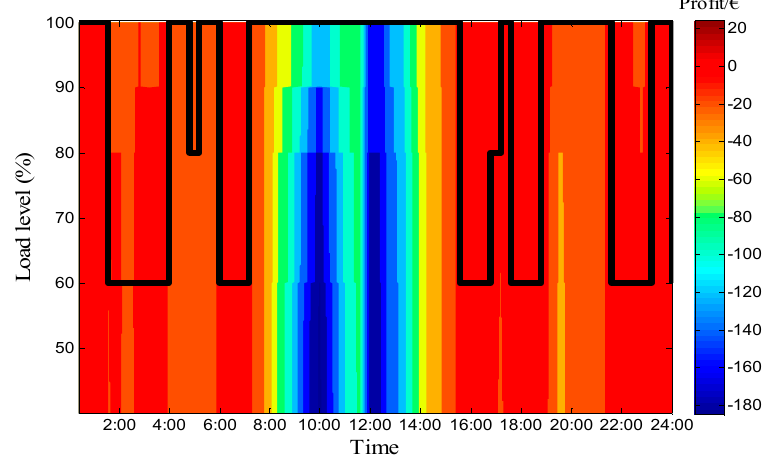
Figure 10. Profit distribution for CHP in real time.